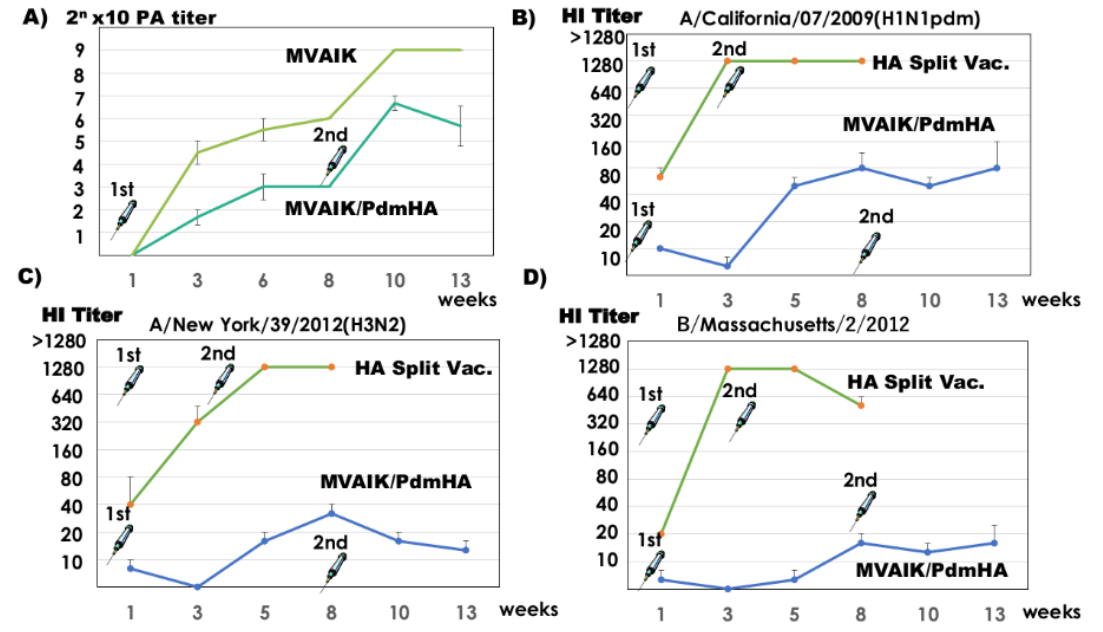
Figure 3. Serological responses in cotton rats immunized with influenza HA split or recombinant MVAIK/PdmHA vaccines. ( A ) Development of measles PA antibody. Vertical lines represent mean ± SE. ( B ) HI antibody against influenza A/California/07/2009(H1N1pdm), ( C ) HI antibody against influenza A/New York/39/2012(H3N2), and ( D ) HI antibody against influenza B/Massachusetts/2/2012. Vertical lines represent mean + SE.